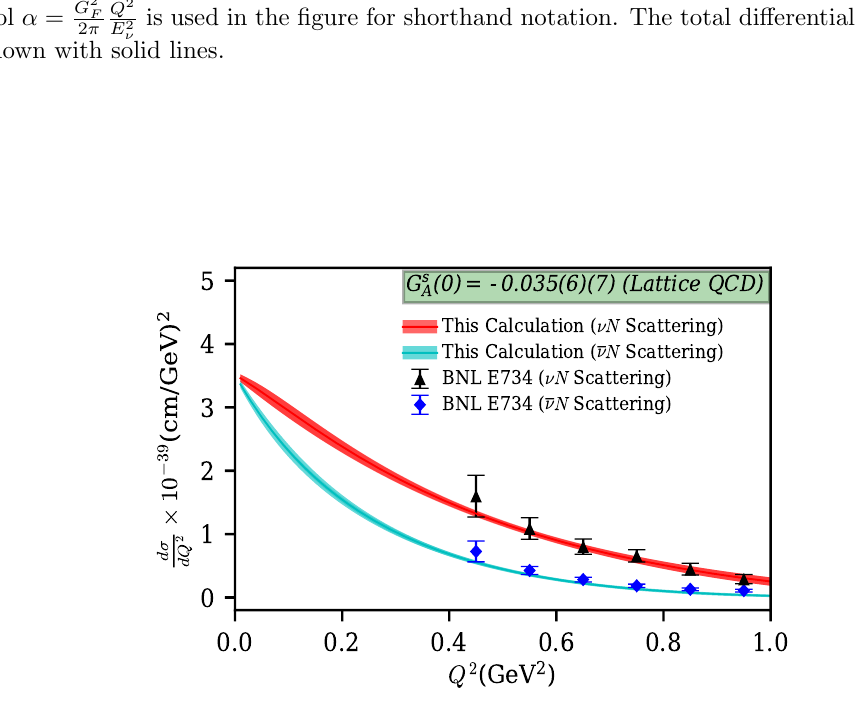
( Q 2 ) to (cid:23)p and (cid:23)p A